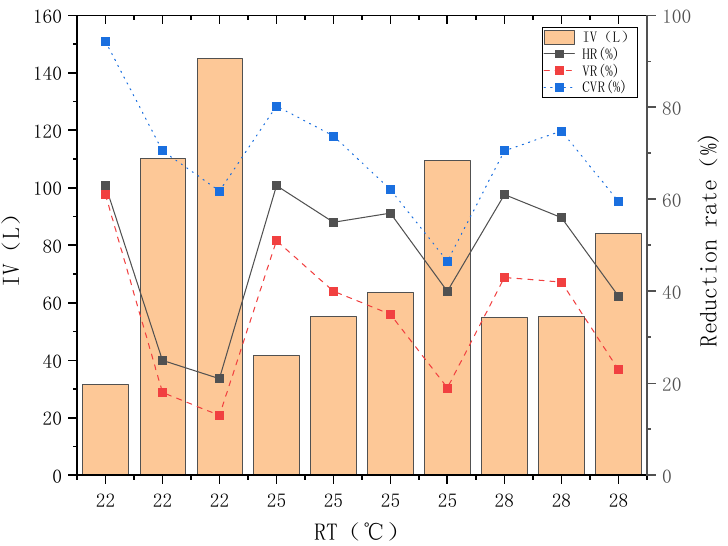
Figure 3. Experimental results of thermal pollution in bioretention facilities. The three figures, representing the reduction rate of heat pollution, the volume reduc- tion rate, and the volume reduction percentage, respectively, trend more closely together in Figure 3. On this basis, taking the volume reduction rate of VR as the x -axis, the linear fitting relationship between VR and CVR can be obtained, as shown in Figure 4 below.